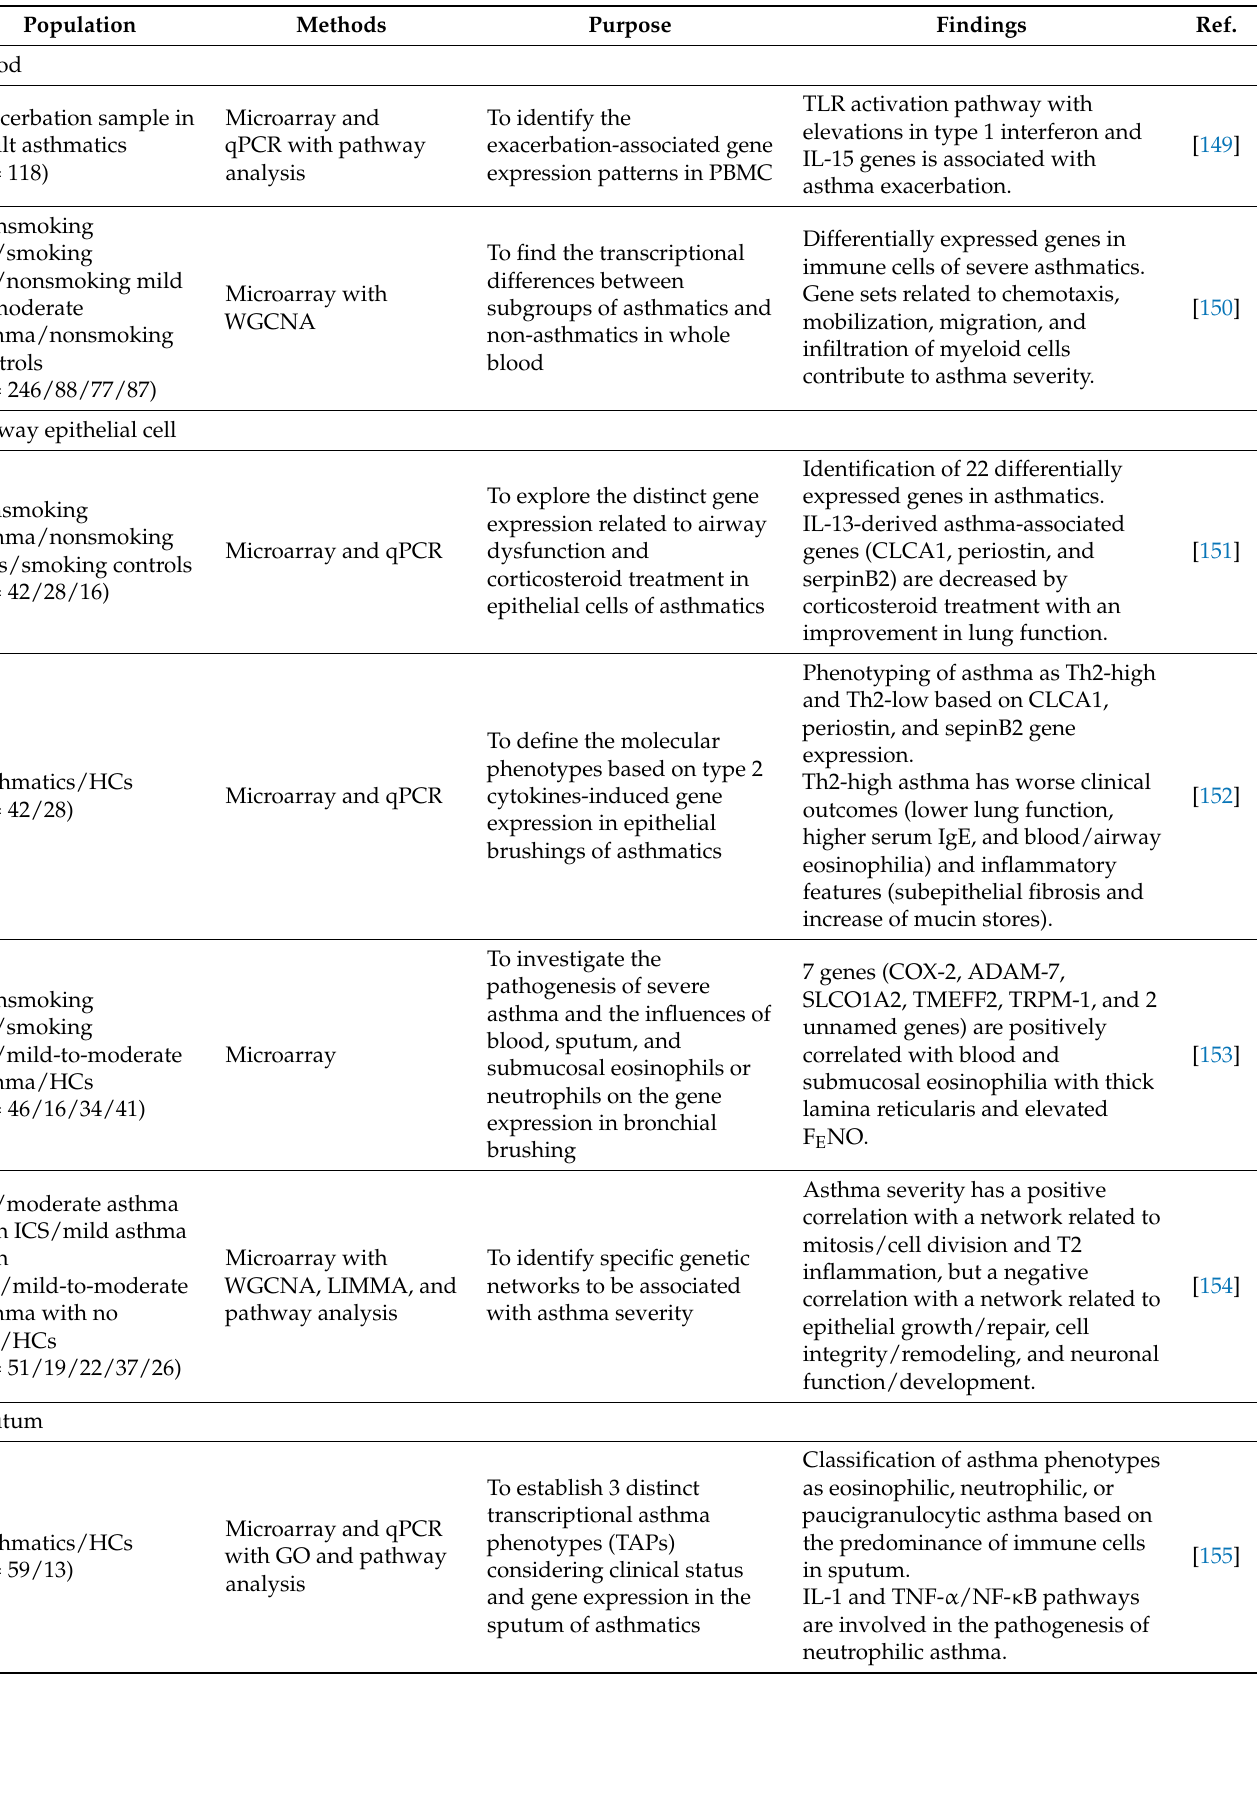
Table 2. Summary of transcriptomic analyses in adult